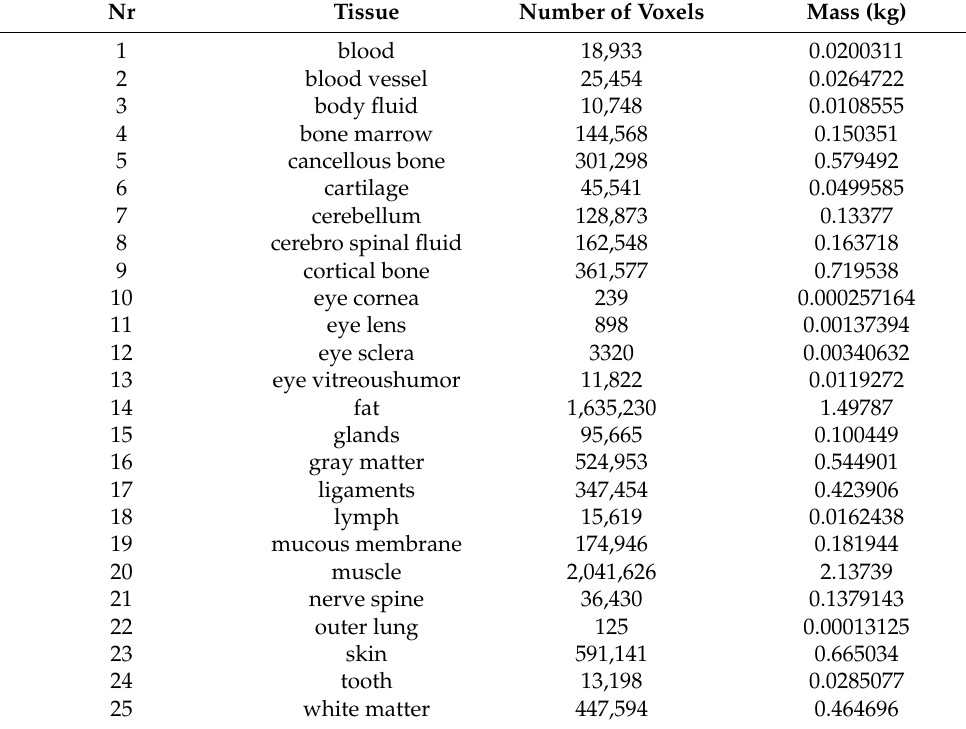
Table A1. Human body model parameters.